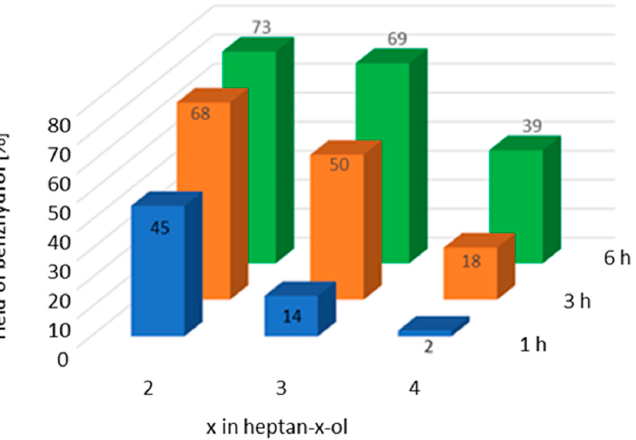
Figure 1. Liquid phase transfer hydrogenation of benzophenone with heptan-x-ols (x = 2, 3 or 4) in the presence of MgO. Reaction conditions: W MgO = 250 ± 5 mg, 3.125 mmol of ketone, D/A = 8, selectivity >98%.